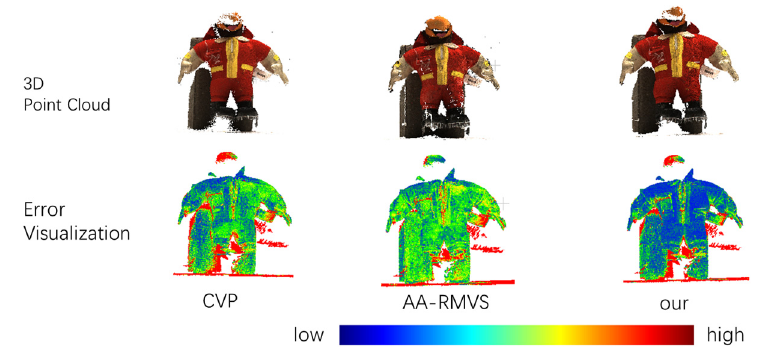
Figure 5. Error Visualization of DTU Dataset.